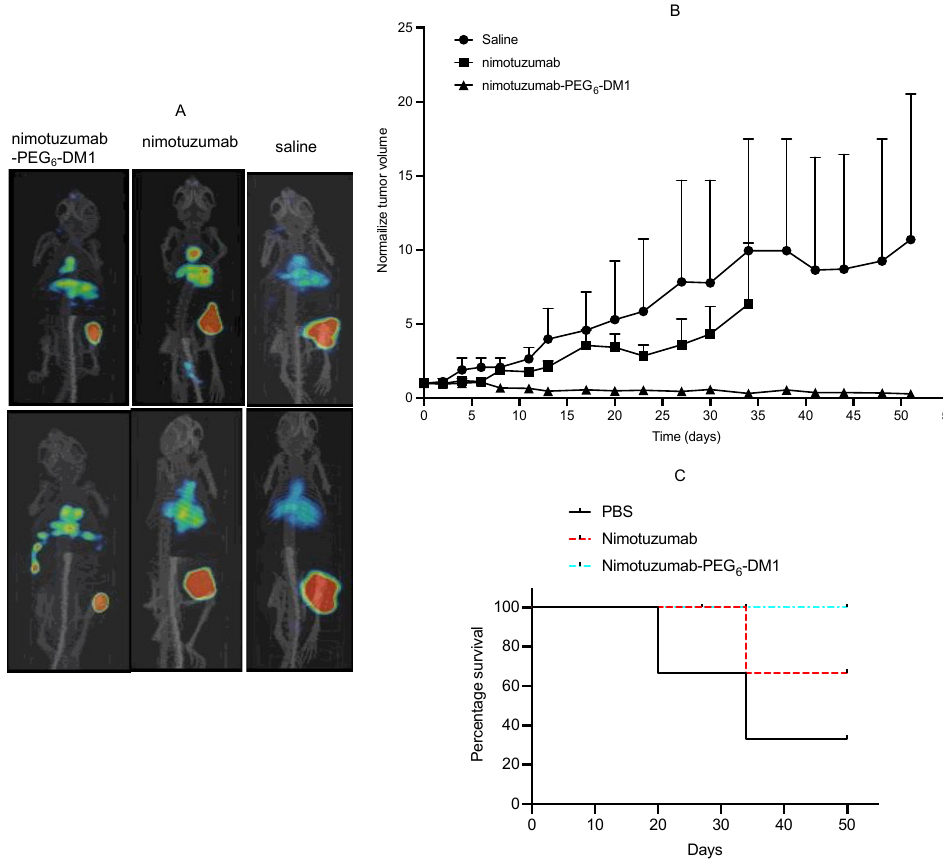
Figure 8. Epitope-specific treatment of mice bearing an EGFR-positive colorectal cancer xenograft SNU-C2B using nimotuzumab-PEG 6 -DM1, and monitoring of response to treatment using 89 Zr- matuzumab. ( A ) MicroPET/CT images of 89 Zr-matuzumab on days 0 (upper panel/row) and 20 (lower panel/row) after treatment. Mice were treated on days 0, 6, and 11 using nimotuzumab-PEG 6 - DM1 ADC. ( B ) Tumor growth curves of mice treated using nimotuzumab-PEG 6 -DM1, nimotuzumab, or untreated (saline), and ( C ) Kaplan–Meier survival curves of treated and untreated mice.